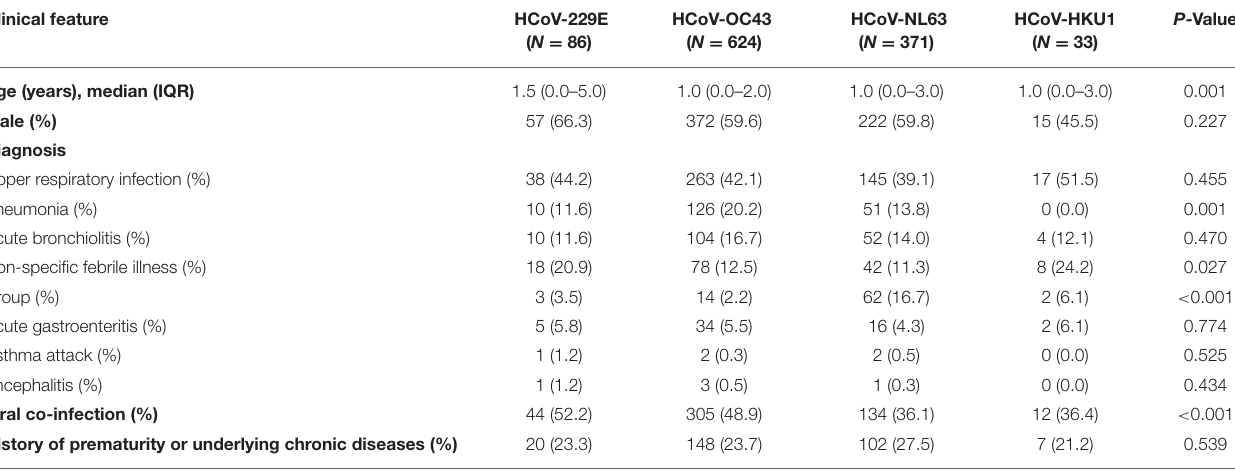
TABLE 3 | Clinical characteristics associated with each type of HCoV detection.